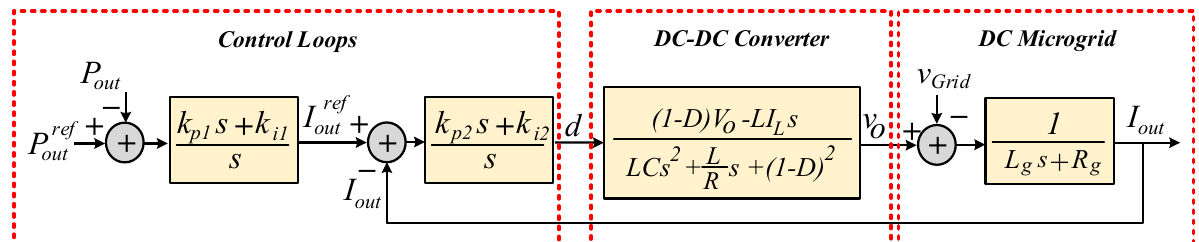
Figure 4. System modeling in s-domain in normal